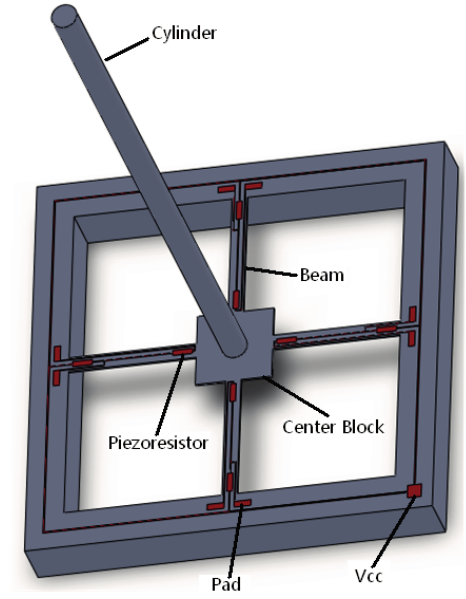
Figure 3. Microstructure model graph of sensor.